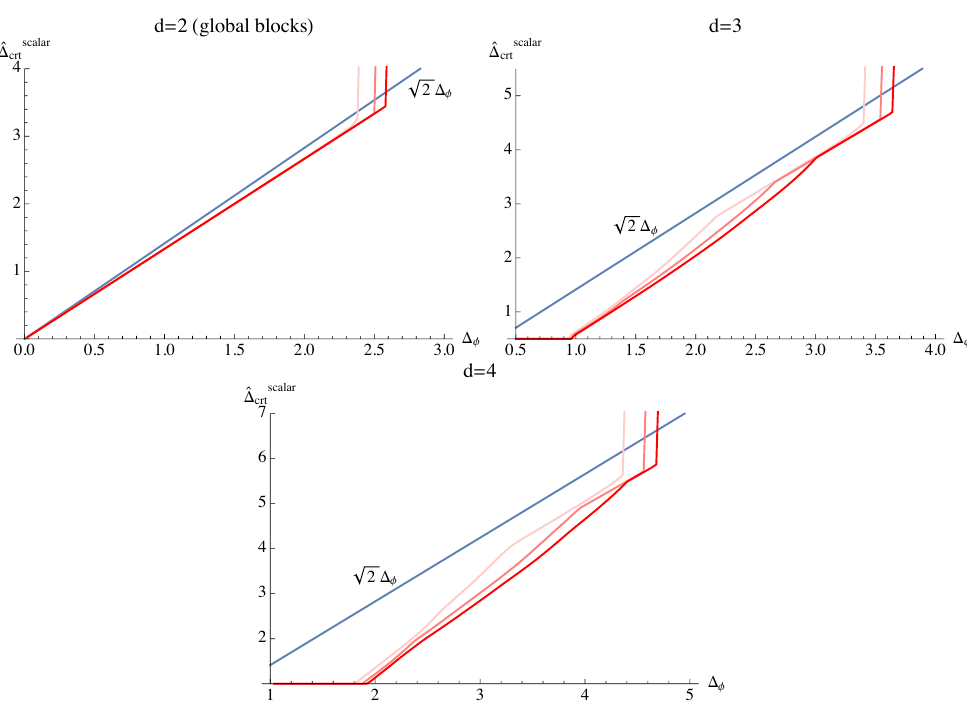
Figure 8 . Upper bounds on b (cid:1) scalar as a function of (cid:1) (cid:30) in 2 dimensions (using global conformal crt blocks), 3 dimensions, and 4 dimensions. The blue line shows the analytic bound p 2(cid:1) (cid:30) on b (cid:1) crt . The red bounds are computed numerically with derivative order 12 ; 20 ; 28, with the darkest line and strongest bound corresponding to derivative order 28. For (cid:1) (cid:30) . 1 in 3d and (cid:1) (cid:30) . 2 in 4d,